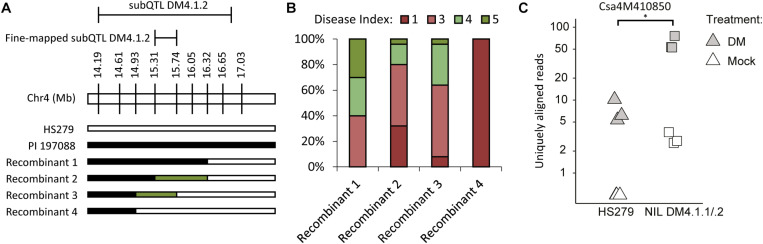
Fine-mapping and candidate gene expression subQTL DM4.1.2. (A) Screening of individuals derived from the mapping population allowed identification of additional informative recombinants within the DM4.1.2 interval. Bars represent genotypes at marker locations. Black bars indicate the PI 197088 allele, white bars indicate the HS279 allele, and green bars represent heterozygosity. (B) Populations were developed by self-fertilization of the recombinants described in A. 10–25 seedlings of each of the four populations was sown and used for a disease test. Sporulation was scored at 14 dpi on a scale from 1 to 9 as described before. Stacked bars represent the distribution of disease phenotypes in each of the four populations. (C) Expression data of gene Csa4M410850, encoding an RLK gene within the fine-mapped interval of DM4.1.2 interval, was extracted from the RNAseq dataset and plotted per sample on a logarithmic scale. No expression of this gene was detected in any of the mock-treated samples of the susceptible genotype HS279, but for visualization purposes, a 0.5 pseudocount was added. The asterisk denotes a significant difference between both genotypes in P. cubensis inoculated samples (adjusted p < 0.05). Differences between mock-treated and P. cubensis inoculated samples were also statistically significant (adjusted p < 0.05).